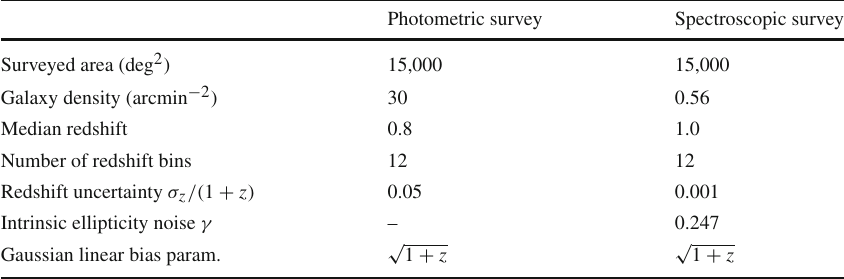
Table 23 Forecast 1 σ errors for the nonlinearity parameter f NL based on two-point statistics (power spectra) of the Euclid redshift and weak-lensing surveys Bispectrum shape Local Galaxy clustering (spectr. z ) Galaxy clustering (photom. z